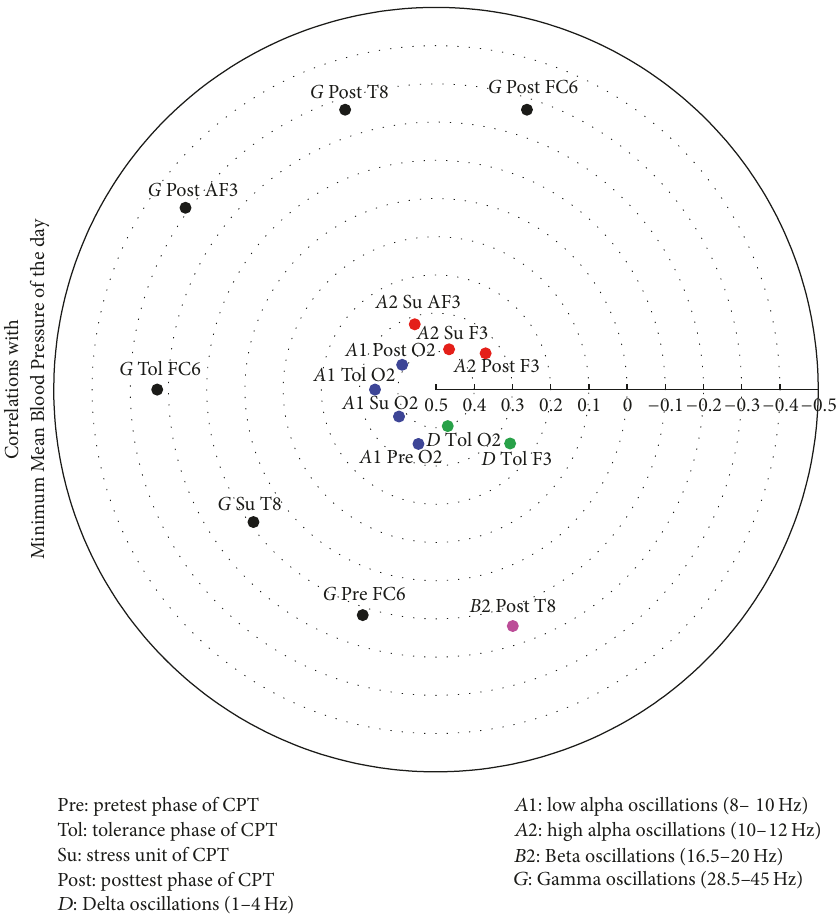
Figure 11: Heliograph of the correlations between Minimum Mean Blood Pressure of the day and the statistically significant different CPT- induced EEG oscillations depicted by concentric circles in the ( − 1)-(0)-(+1)